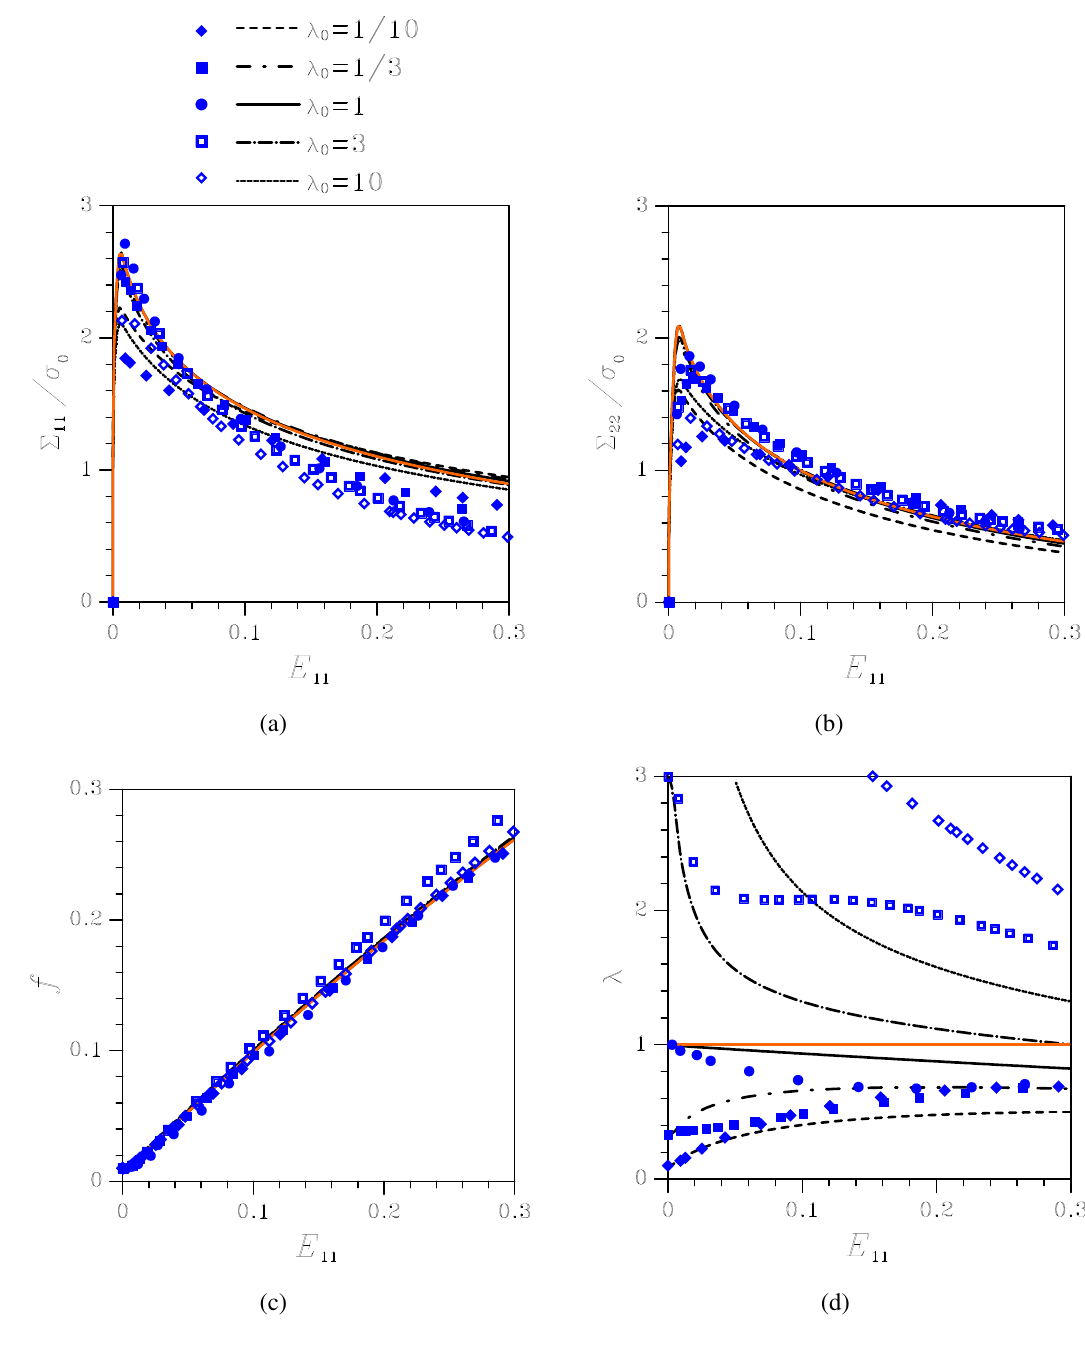
Figure 4 . Effect of the initial aspect ratio λ on the nonlinear response of the orthotropic 0 porous-plastic solid at k = 0 . 0 . Comparison among the proposed constitutive model (black ε lines), the Gurson’s model (orange line), and unit-cell simulations (blue symbols) in terms of: (a) Cauchy stress Σ vs logarithmic strain E ; (b) Cauchy stress Σ vs 11 11 22